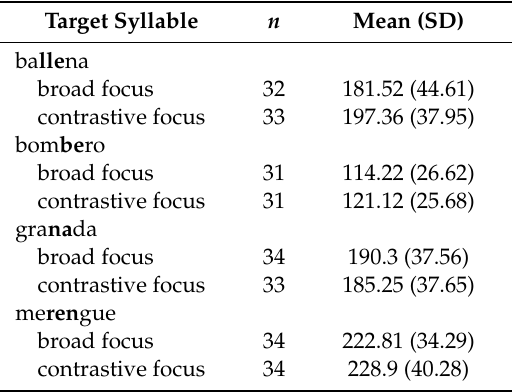
position. Mean duration and standard deviations (SD) are indicated in ms. Mean duration and standard deviations (SD) are indicated in ms.